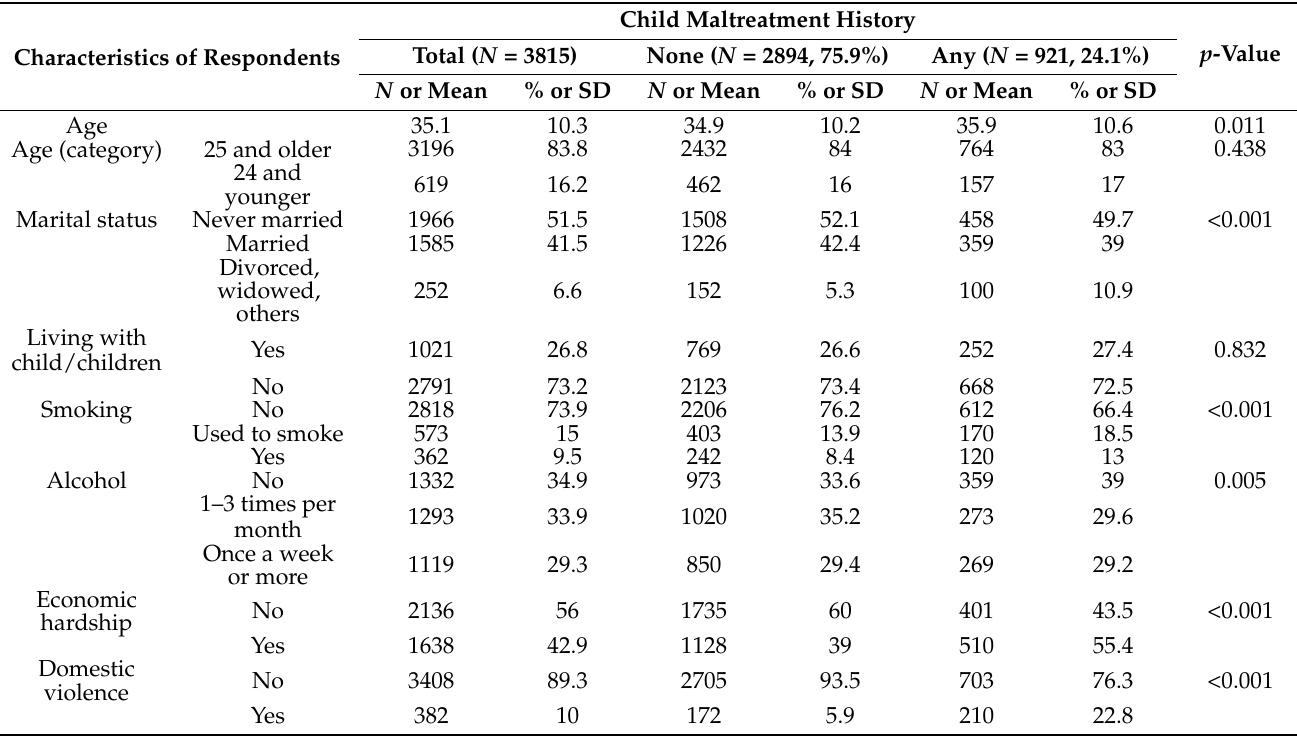
Table 1. Characteristics of respondents ( N = 3815).